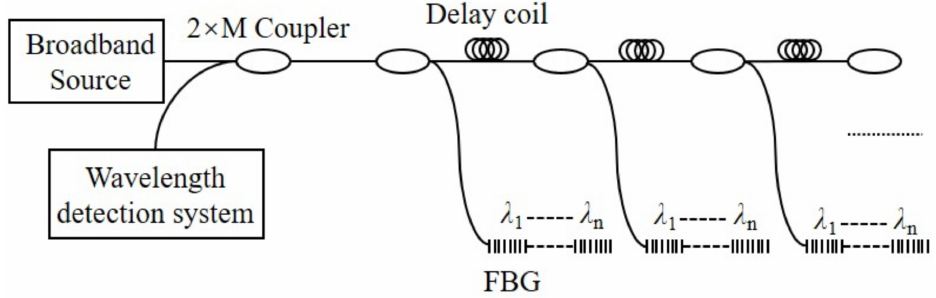
Figure 11. FBG sensor multiplexing technology: